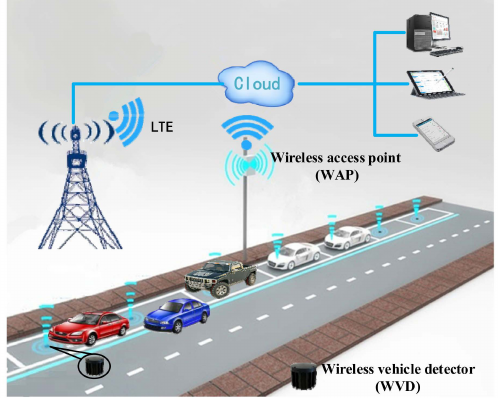
Figure 1. Roadside SPMS